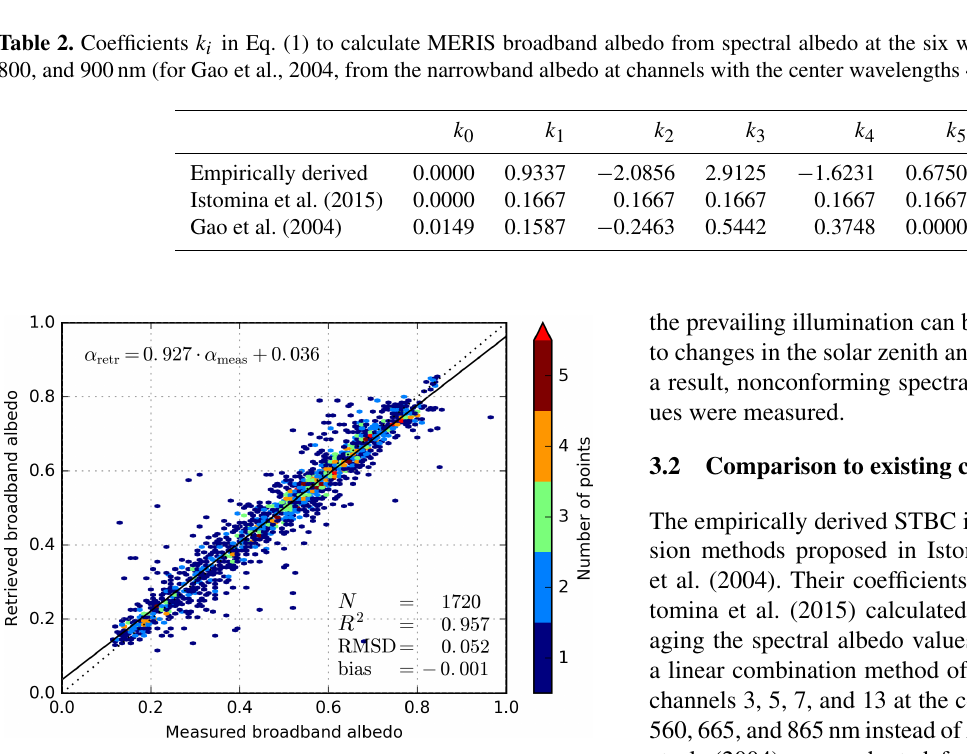
Figure 1. Scatterplot of measured broadband albedo and retrieved broadband albedo by applying the empirically derived STBC to measured spectral albedo. Measurements were done by Polashen- ski (2011) over landfast ice of different melting stages close to Utqia˙gvik, AK, USA, between April and June of 2008 and 2009. Colors indicate the number density of points. The solid and dotted lines indicate the regression and one-to-one line,